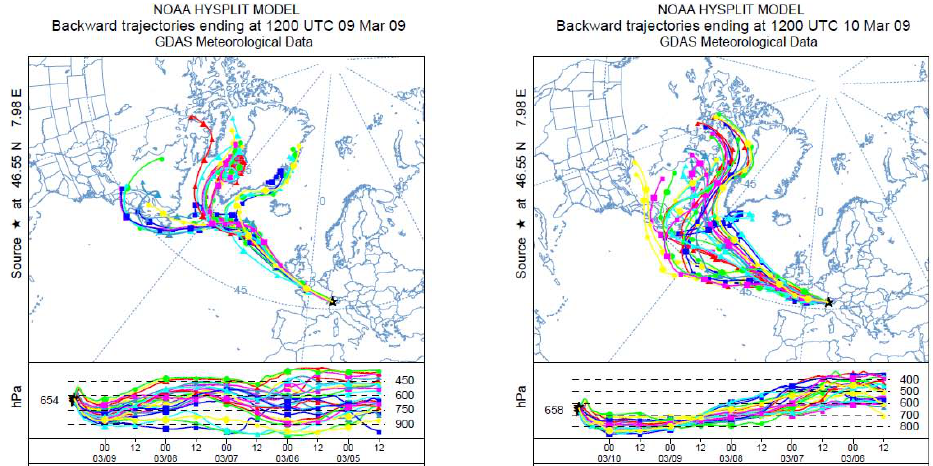
Fig. 6. Four days backtrajectories on 9 and 10 March 2009 at Jungfraujoch at 12:00p.m.